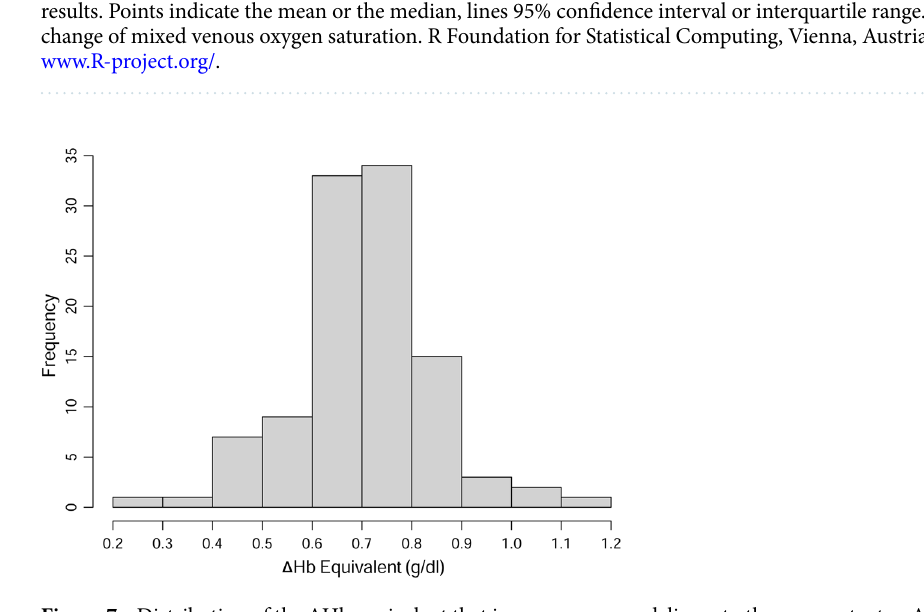
Figure 7. Distribution of the ΔHb equivalent that increases oxygen delivery to the same extent as ΔFiO 2 of 0.5. ΔHb, change of hemoglobin concentration. Created with R: A language and environment for